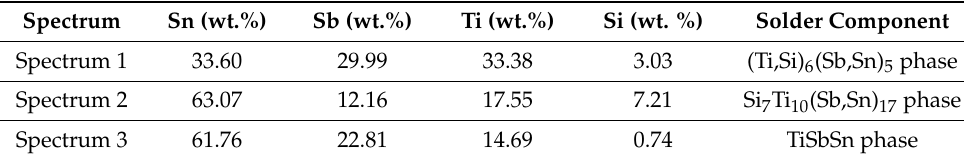
Figure 18. Representation of measuring points on the SiC/Sn5Sb3Ti interface. Figure 18 . Representation of measuring points on the SiC/Sn5Sb3Ti interface. Table 7. Point EDX analysis of the boundary in the SiC/Sn5Sb3Ti Table 7. Point EDX analysis of the boundary in the SiC/Sn5Sb3Ti joint .